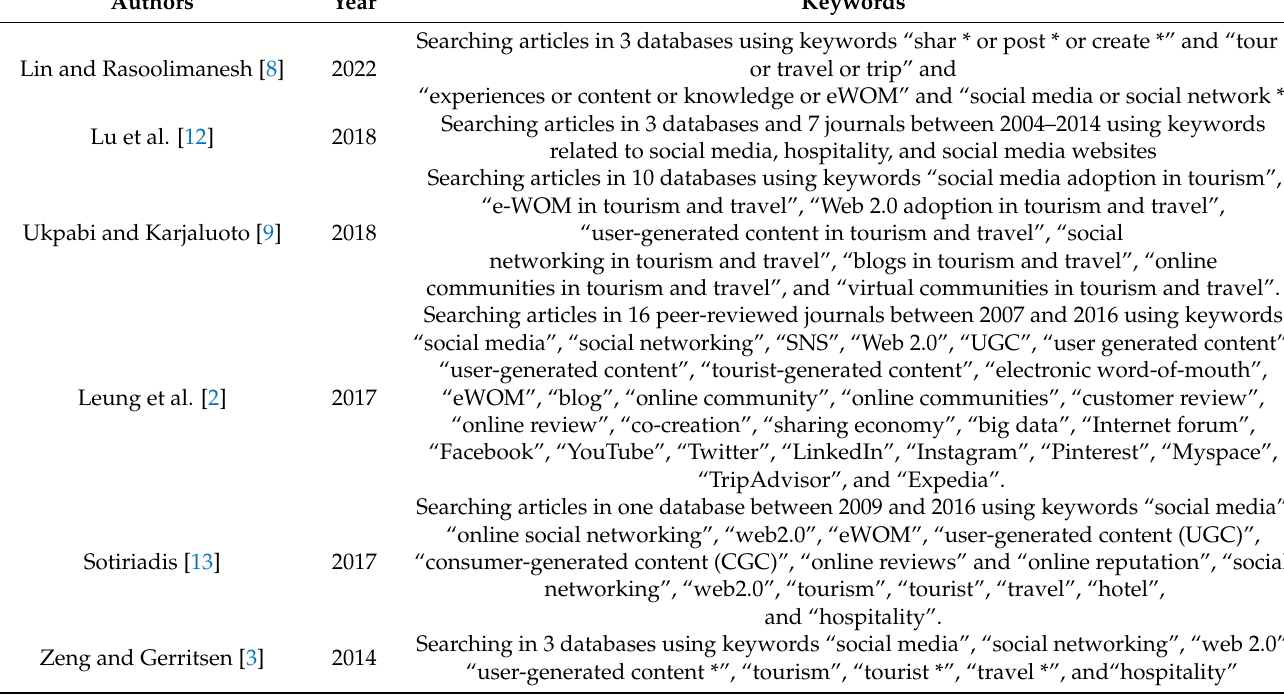
Table 1. Previous literature reviews. The asterisk was used to include all the productions of the